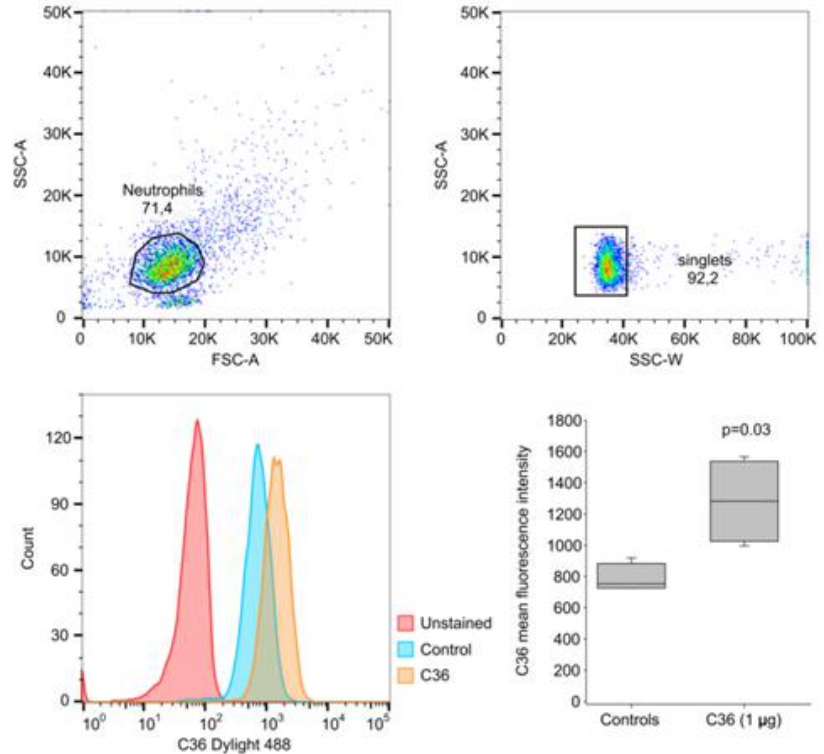
Figure 7. Flow cytometry analysis of C-36 peptide in human neutrophils. Neutrophils (1.5 × 10 6 cells per condition) were incubated with or without C-36 peptide (1 µ g/mL), for 2 h. Cells were then collected and processed as described in materials and methods. Staining was performed with DyLight488 conjugated C42 mAb. Samples were measured with Guava EasyCyte flow cytometer, and data analyzed with FlowJo v10. Unlabeled cells were used as controls to set the flow-cytometry parameters. After incubation with C-36, neutrophils show significantly increased positive staining for the C-36 in comparison to untreated cells. Box and whisker plots lines represent means (SD) of four independent experiments. P was calculated based on the Shapiro–Wilk normality